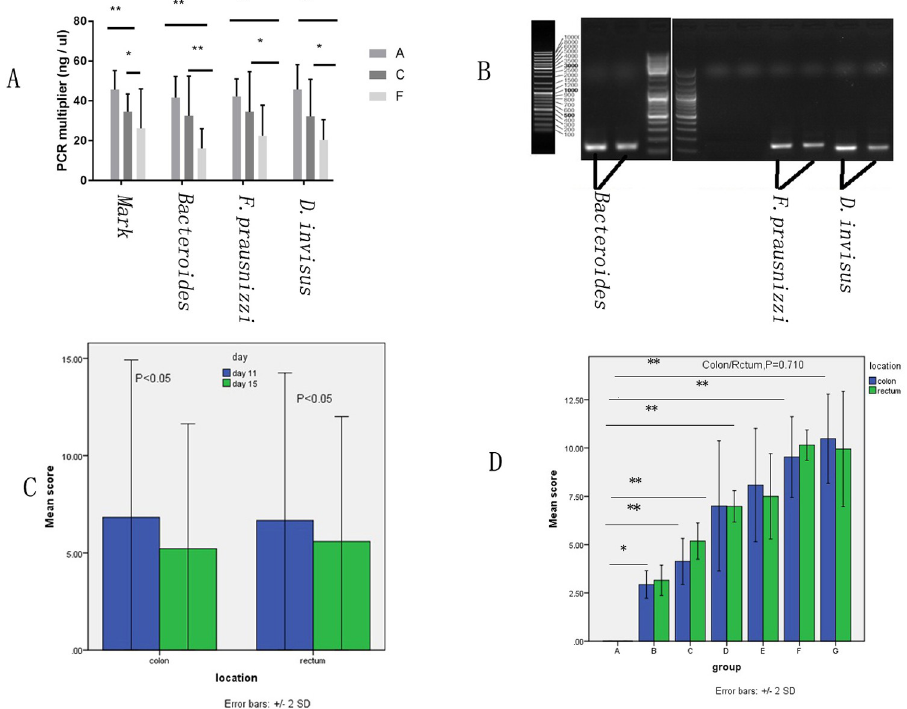
Fig 6. Fecal bacterial content and gut inflammation scores. (A) Comparison of bacterial amplification via quantitative PCR in groups A, C and F;(B) Bacteroides , F . prausnitzii and D . invisus agarose electrophoresis; (C) Comparison of colonic and rectal tissue inflammation scores on day 11 and day 15;(D)Comparison of colonic and rectal tissue inflammation scores of control group vs experiment groups respectively, � P < 0.05, �� P < 0.01.